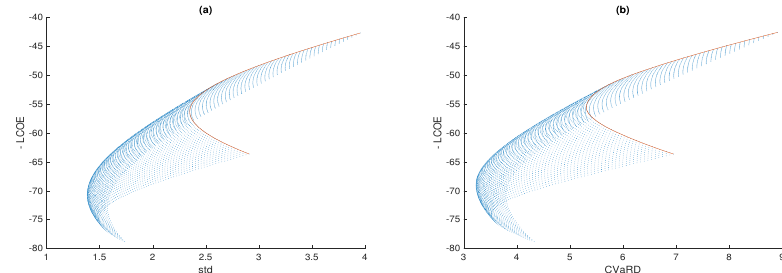
Figure 3. Power portfolio opportunity sets under the stochastic NPV metric. The 40-year plant lifetime scenario: ( a ) the standard deviation case; ( b ) the CVaRD case. In the y -axis, NPV stands for expected NPV. Continuous red lines depict two-asset, gas and coal, portfolio opportunity sets.